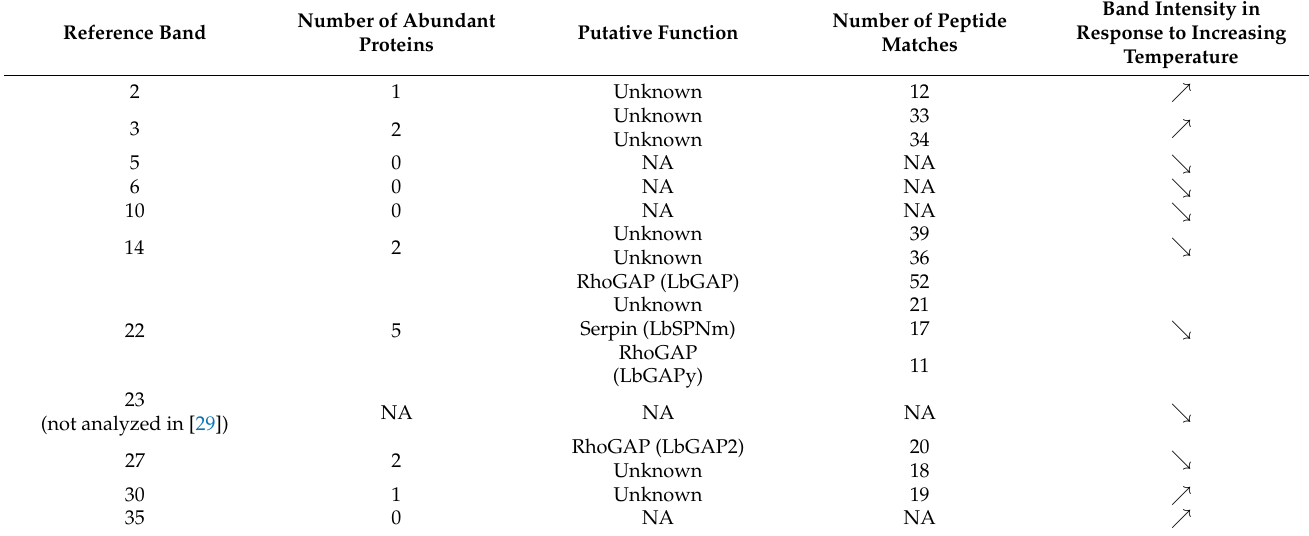
Table 1. Match between temperature-affected ISm protein bands and their putative protein content determined from comparison with data from [29]. Only proteins for which at least 10 peptide matches were found in Mascot searches with unisequences identified in the venom apparatus transcriptomics [29] were considered abundant and were therefore listed. The number of proteins found in the band, their predicted function and the number of peptide matches for each unisequence are provided. Up (“ (cid:37) ”) and down (“ (cid:38) ”) arrows indicate an increase or decrease in band intensity in response to increasing temperature. NA: data not